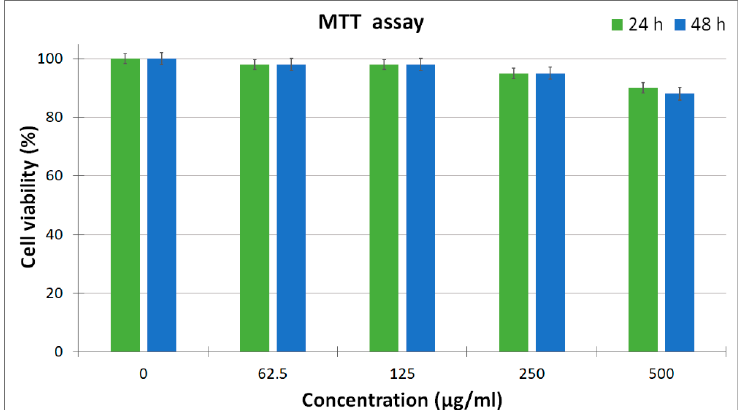
Figure 12. MTT (3-(4,5-Dimethylthiazol-2-yl)-2,5-Diphenyltetrazolium Bromide) assay of HEK-293 cell viability for 24 and 48 h cultured with the ZnHApD nanoparticles. All values were represented as average ± standard deviation for n = 3 per experimental condition. Polymers 2019 , 11 , x FOR PEER REVIEW